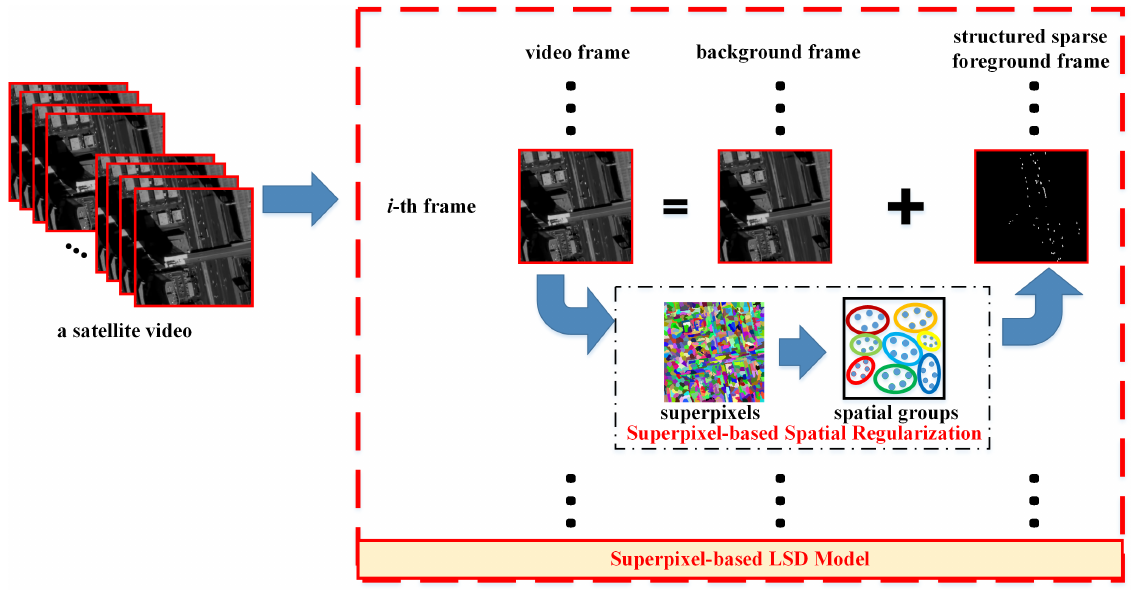
Figure 1. Illustration of S-LSD for moving object detection in satellite